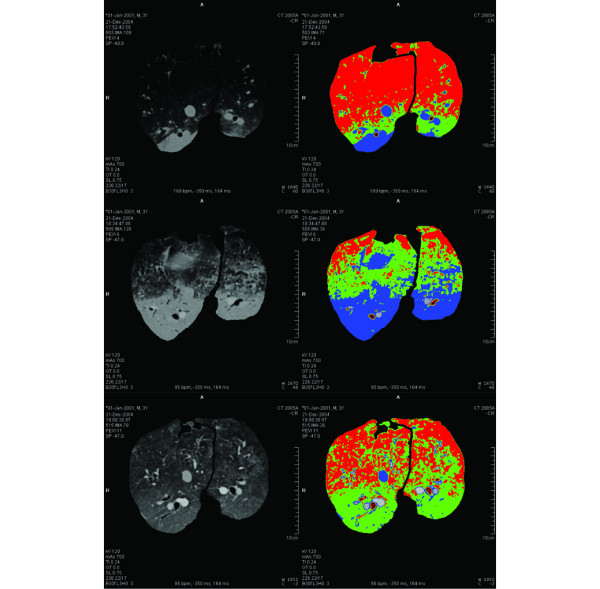
Computed tomography scan examples of basal lung areasduring expiration. Upper two scans, during baseline, before lung lavage. Middle two scans, conventional mechanical ventilation after lung lavage. Lower two scans, during open lung ventilation after lung lavage. Good aerated lung areas (-1000 Houndsfield units (HU) to -600 HU) are coded red in the right-hand scans, poorly aerated areas (-600 HU to -200 HU) are coded green, and non-aerated lung areas (-200 HU to +200 HU) are coded blue.